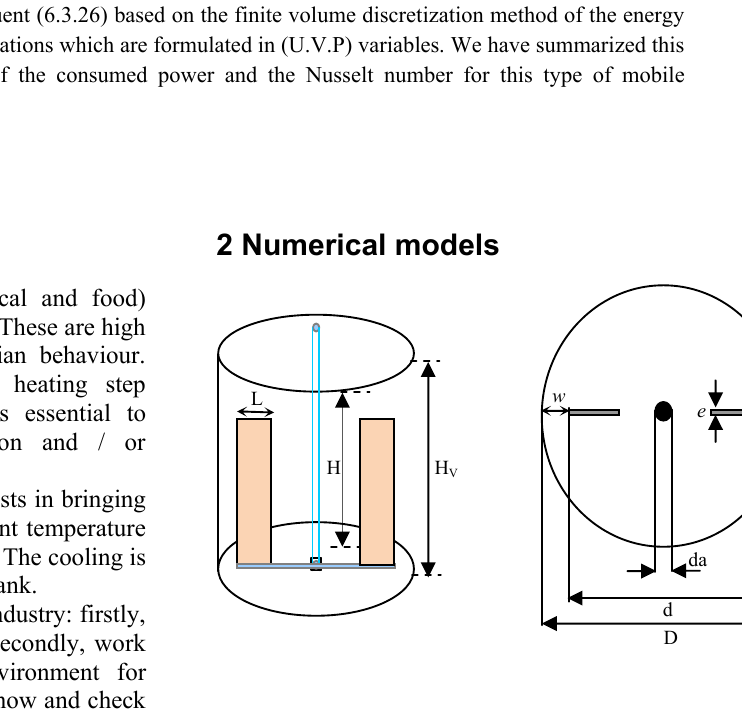
Fig. 1. The geometry of mixing system. The mixing systems are presented in Fig1. The tank is a flat-bottomed vessel (inside diameter: D) equipped with an anchor agitator (diameter d). H is the fluid height. Values for the agitator width ‘L’, agitator-to-wall clearance ‘w’, impairs thickness ‘e’ and geometrical characteristics are reported in Table